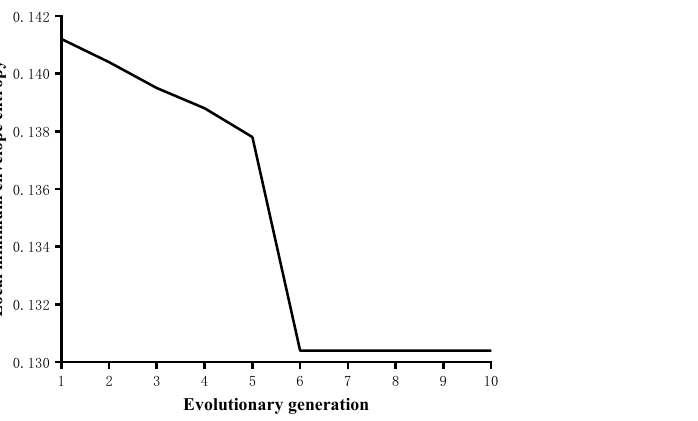
Figure 4. Local minimal envelope entropy values of the simulated signal at different genetic generations.